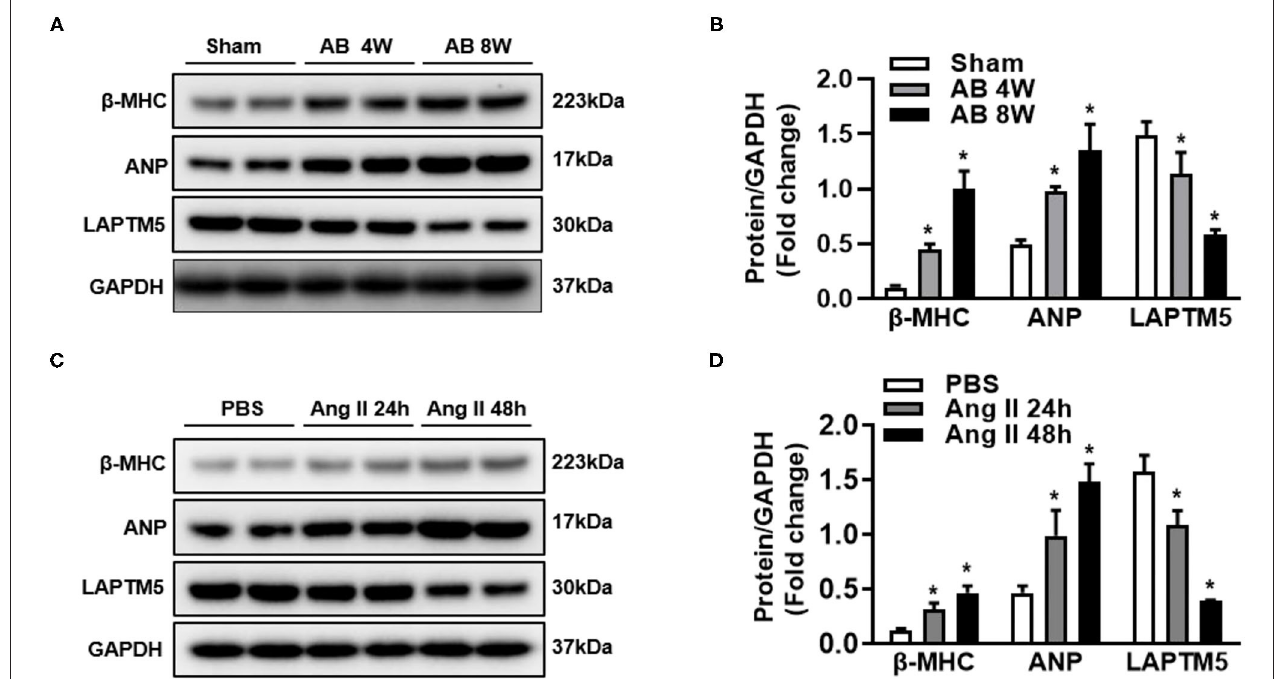
FIGURE 1 | Expression of LAPTM5 is downregulated in experimental hypertrophic models. (A,B) Western blot analysis of β -myosin heavy chain ( β -MHC), atrial natriuretic peptide (ANP) and LAPTM5 levels in hearts from mice subjected to sham or aortic banding (AB) surgery (* P < 0.05 vs. sham). (C,D) β -MHC, ANP and LAPTM5 levels in neonatal rat cardiomyocytes treated with phosphate buffered saline (PBS) or angiotensin II (Ang II; 1 µ mol/L) were detected by western blot (* P < 0.05 vs. PBS).